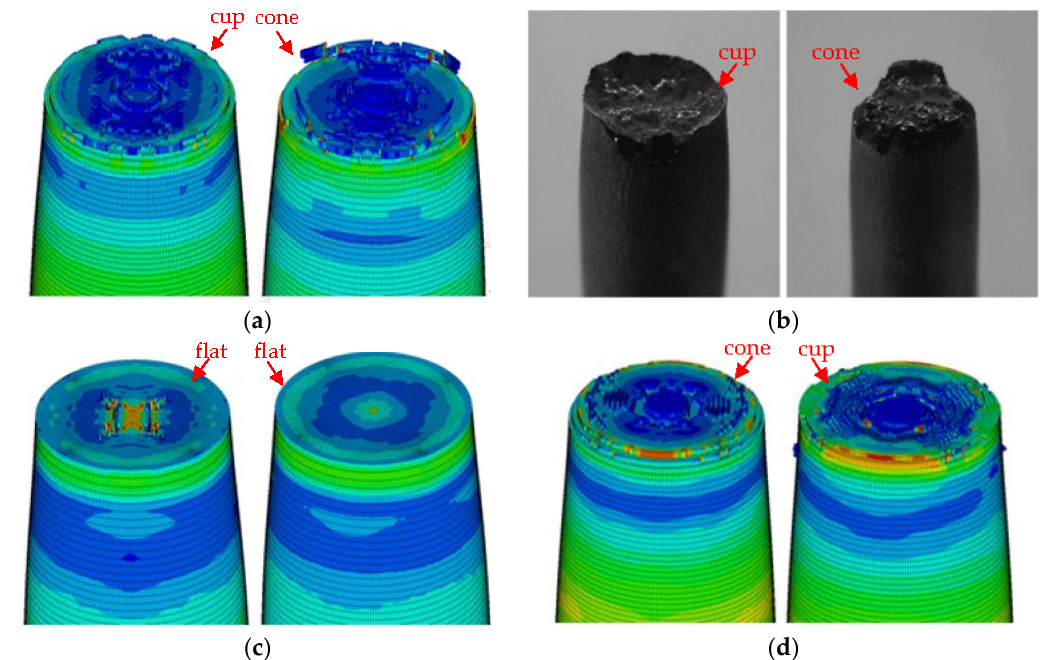
Figure 18. Comparisons of the model predictions with the experimentally observed failure pattern (cup and cone) of the 2024-T351 aluminum alloy smooth round bar specimen in tension at room temperature. ( a ) The present model; ( b ) the experimental observation adapted from [52] with permission from Elsevier, 2008; ( c ) the JC constitutive model with the JC failure criterion; and ( d ) the JC constitutive model with the BW fracture criterion.